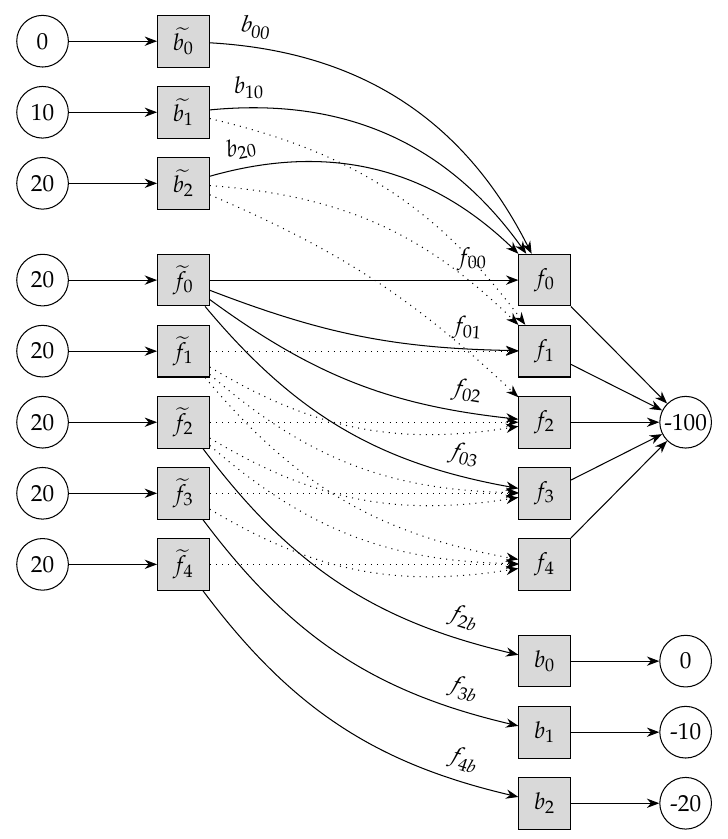
Figure 4. Network flow model for the flexibility